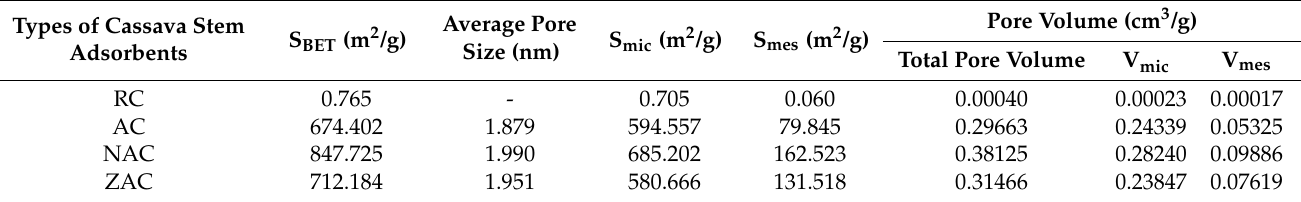
Table 4. Surface areas and pore size for all types of cassava stem